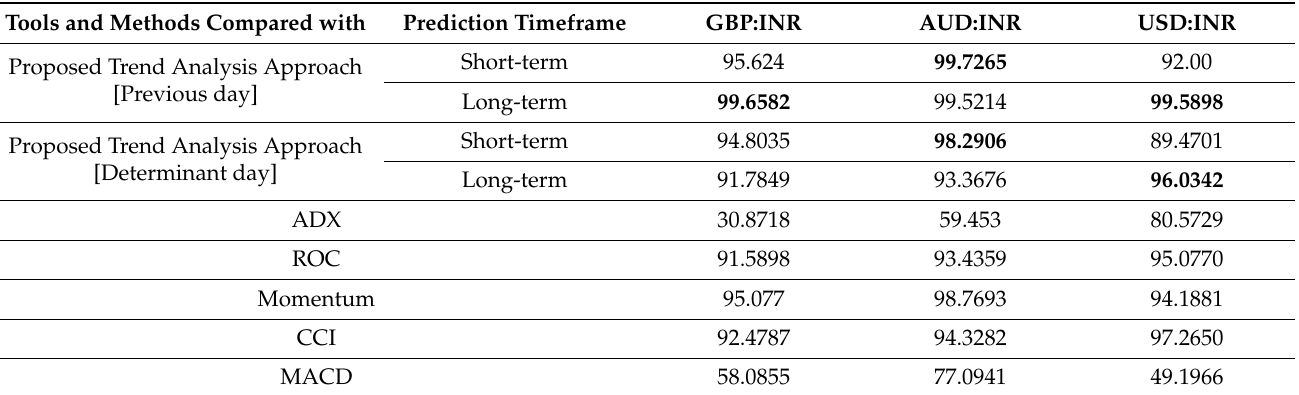
Table 8. Percentage of accuracy (in %) observed during trend analysis with respect to actual trends observed from the original datasets for three currency